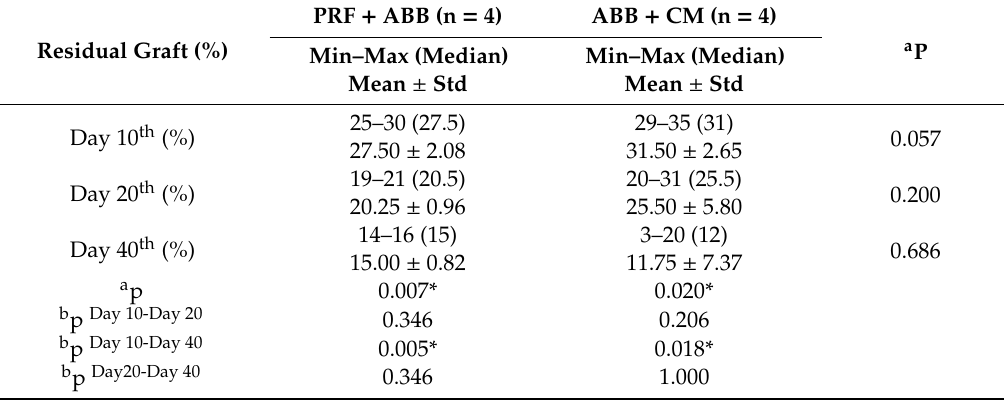
Table 3. Residual graft ratios in both groups on the 10th, 20th, and 40th days.